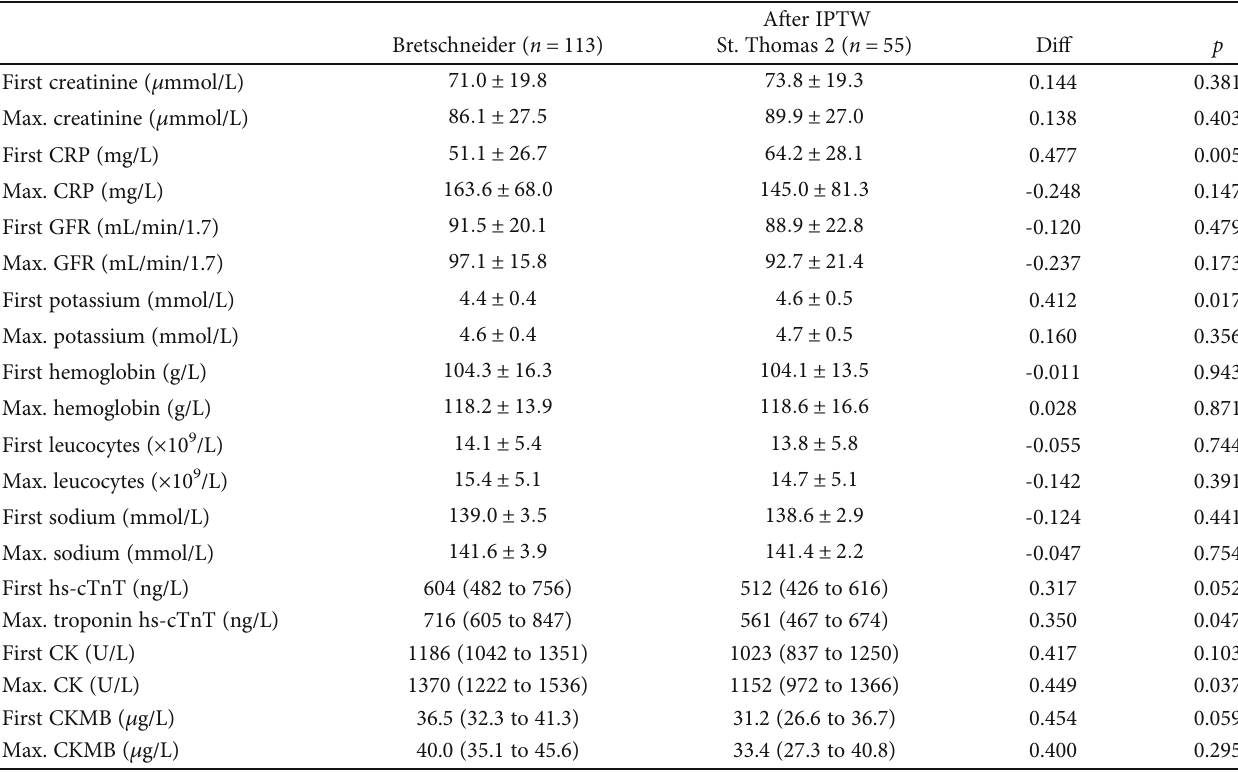
Table 4: Postoperative